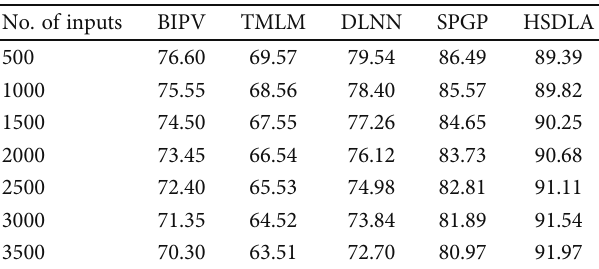
Table 4: Reservation of high energy.